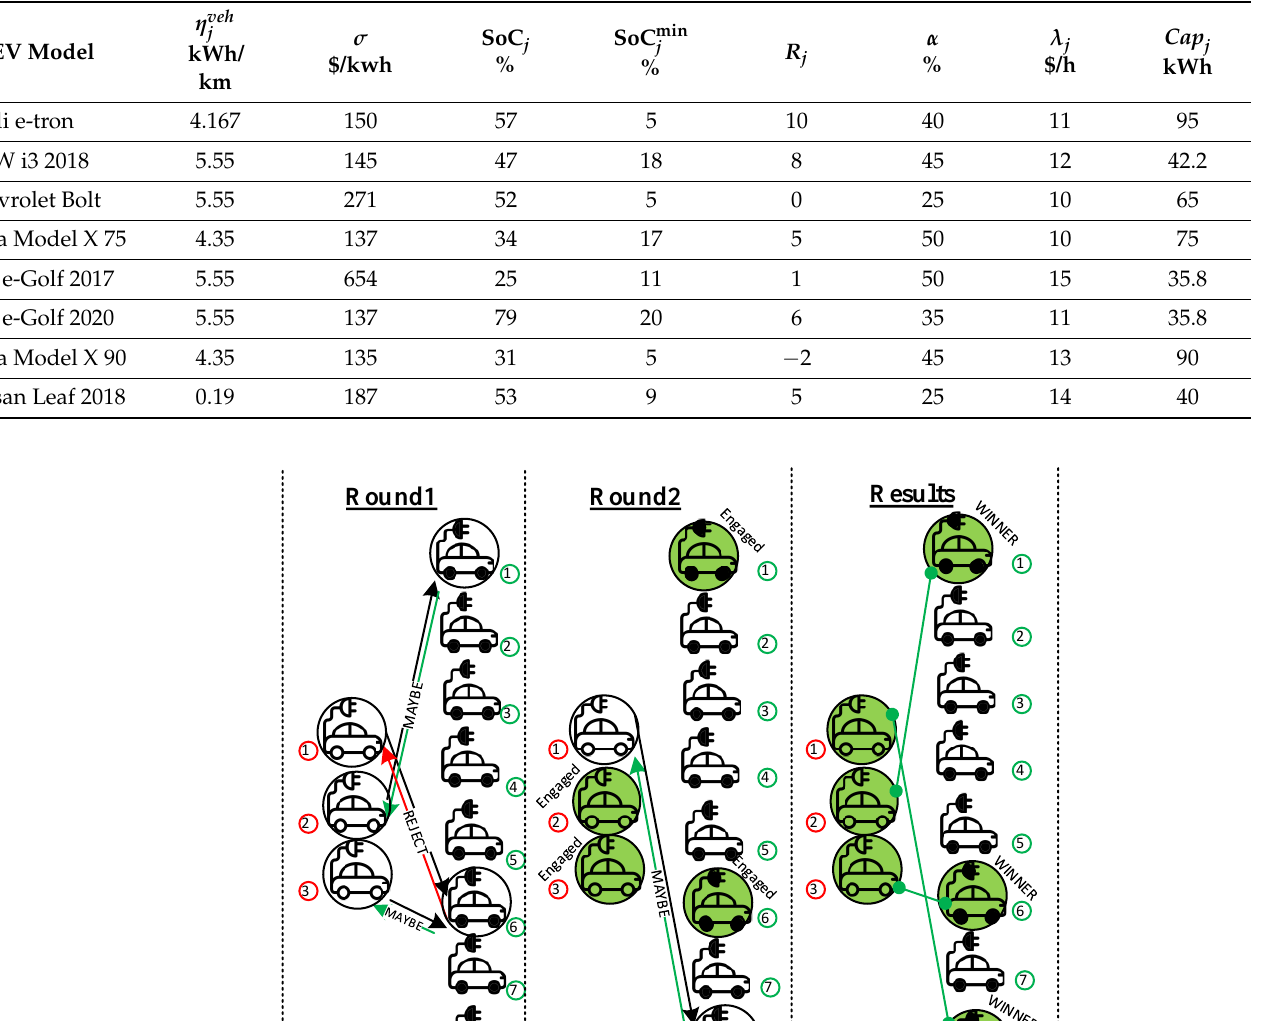
Table 2. Providers initial data.